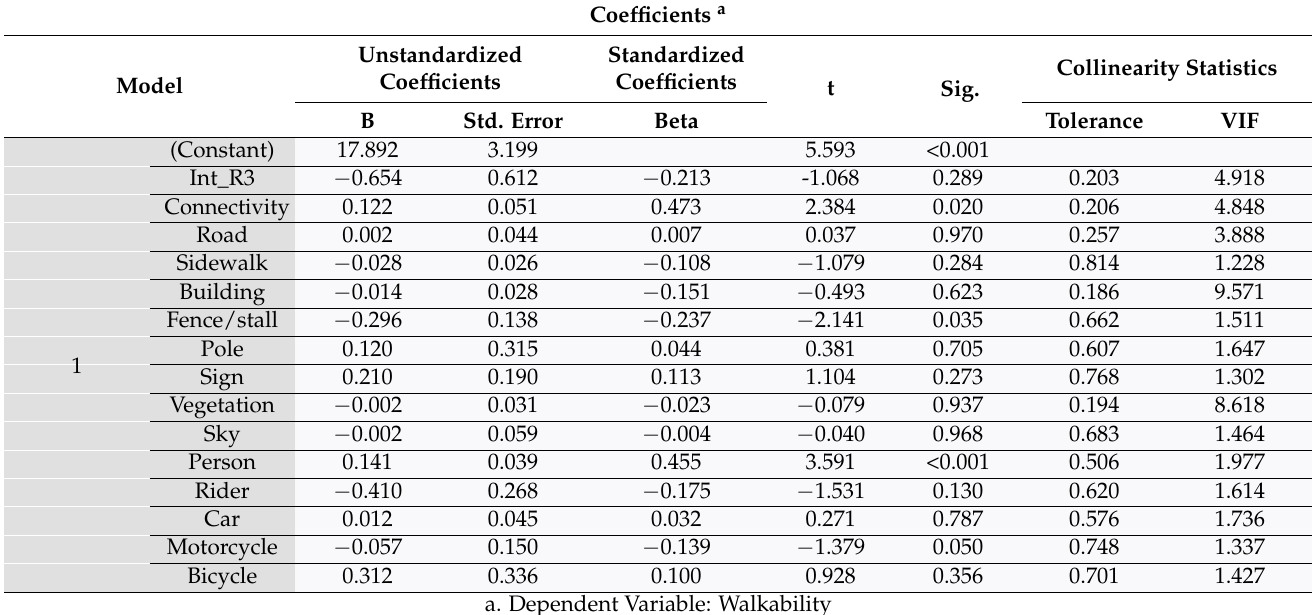
Table 6. Standard Partial Regression Coefficients (2019, before